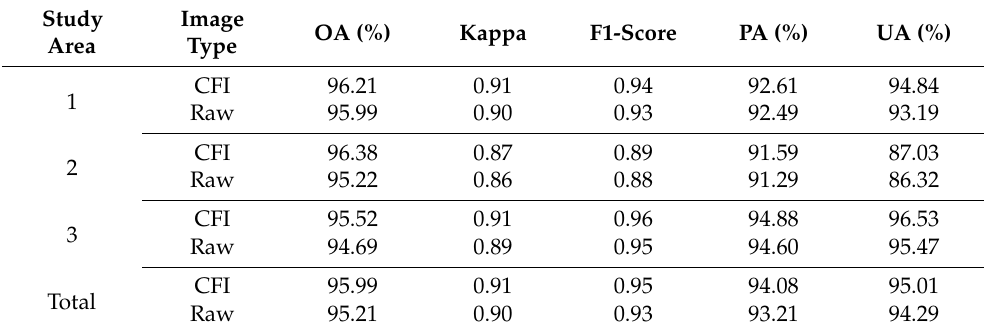
Table 5. Classification accuracy based on CFI images and Sentinel-2 raw images using the RF.